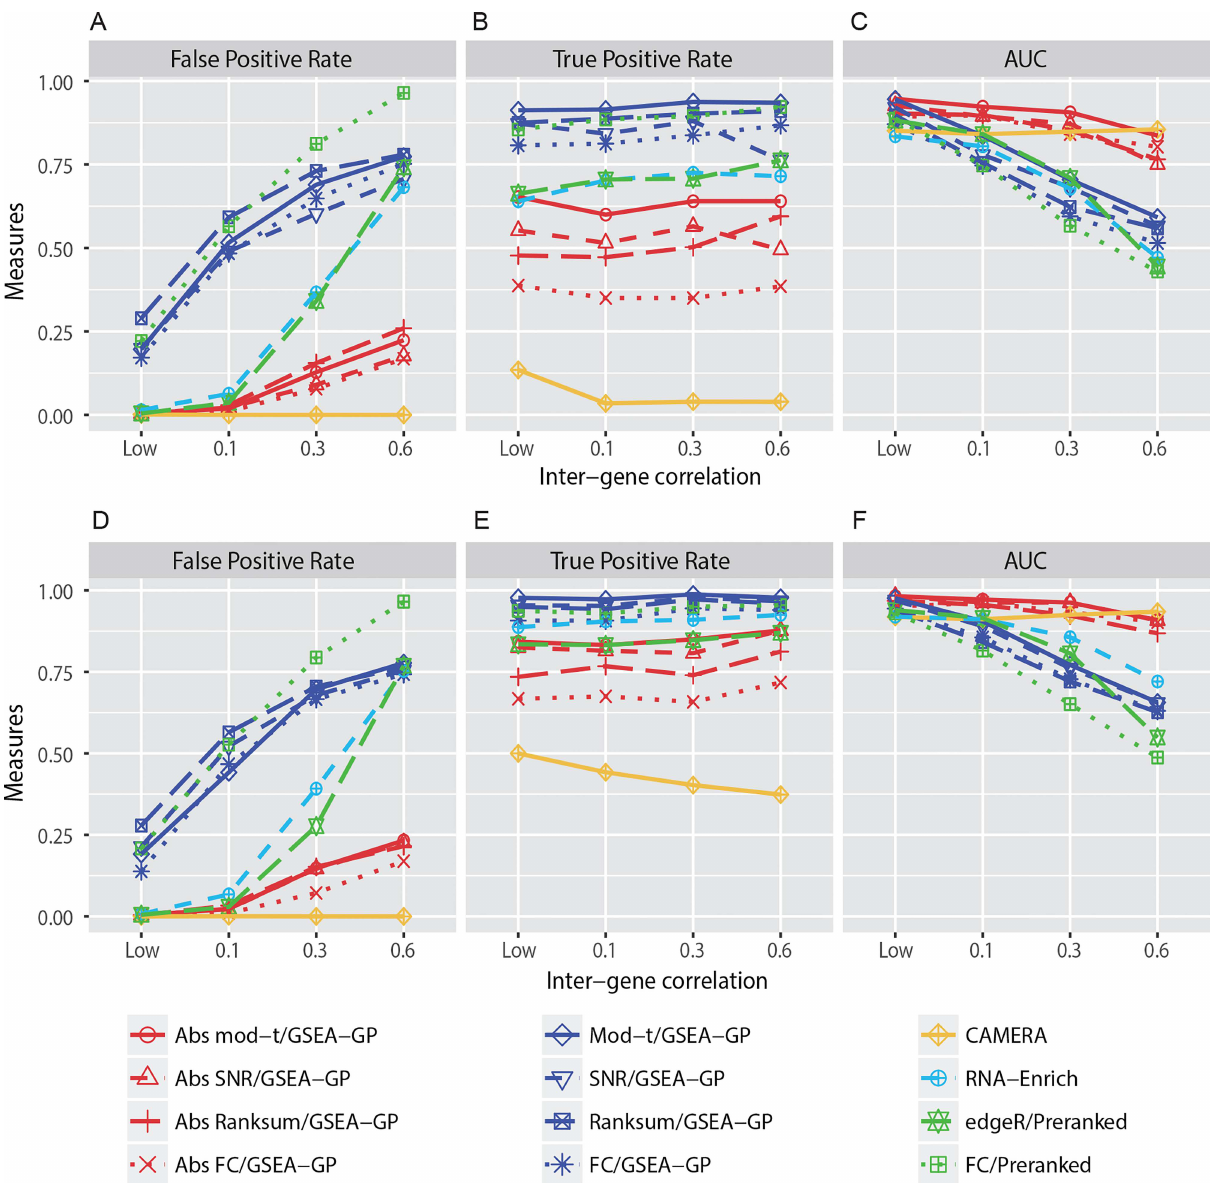
Fig 2. Performancecomparison of gene-permuting GSEA methods for simulated read counts. GSEA-GP methods combinedwith eight gene statistics, (moderated t -statistic, SNR, Ranksum, logFC and their absoluteversions), Camera combinedwith voom normalization, RNA-Enrich and two prerankedGSEA methods for edgeR p -valuesand FCs were comparedfor false positive rate, true positive rate and area under the receiver operating curve using simulatedread count data with three (A-C) and five replicates